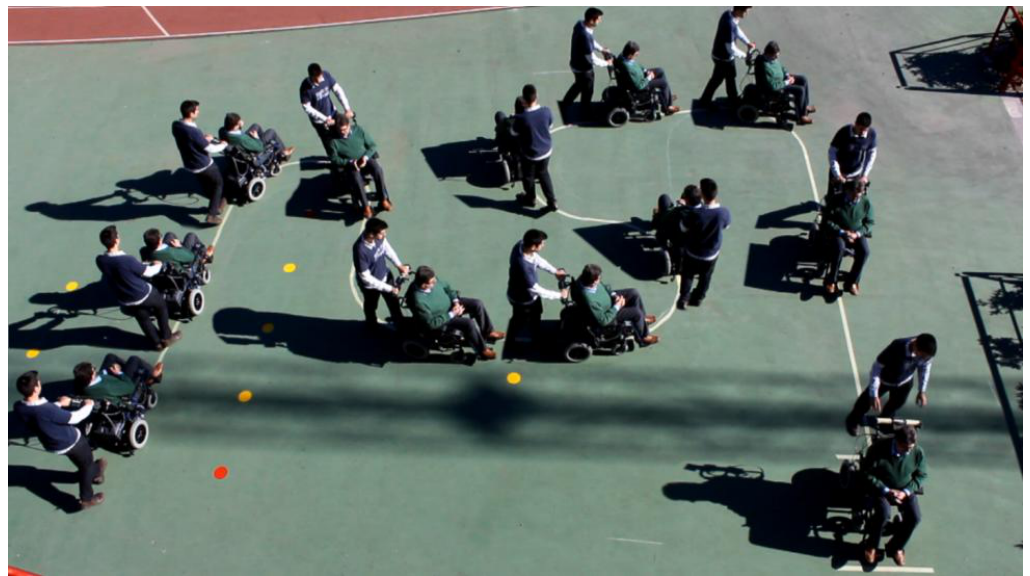
Figure 20. Test circuit: first